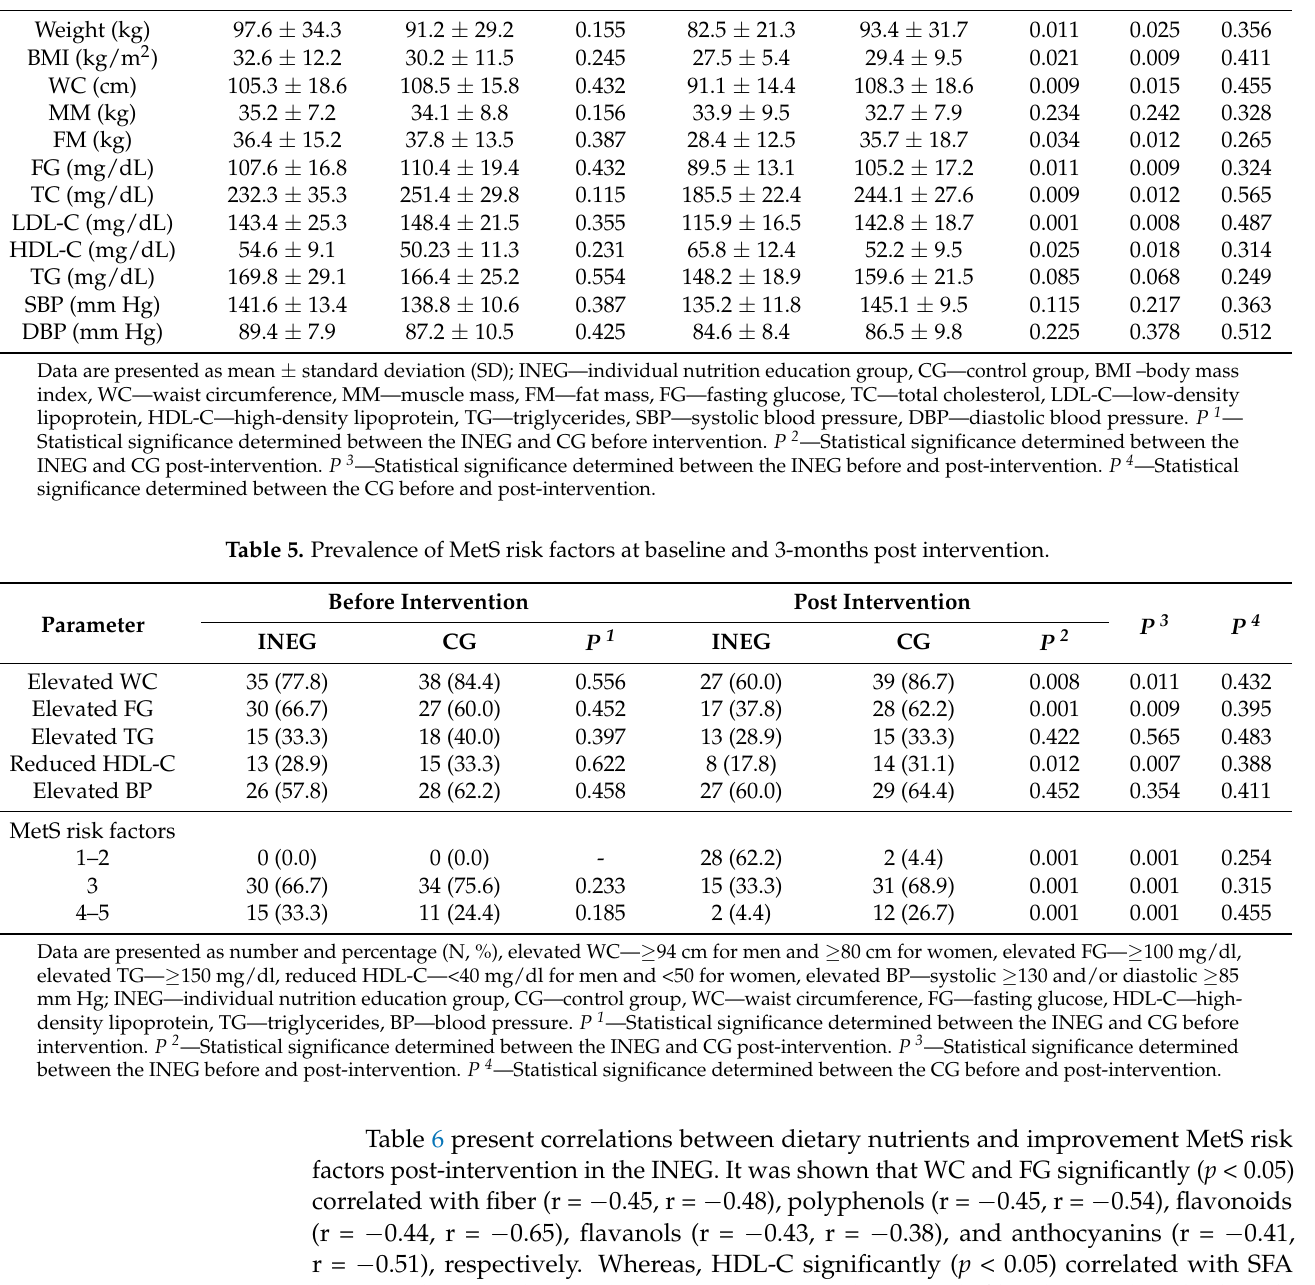
Table 6 present correlations between dietary nutrients and improvement MetS risk factors post-intervention in the INEG. It was shown that WC and FG significantly ( p < 0.05) correlated with fiber (r = − 0.45, r = − 0.48), polyphenols (r = − 0.45, r = − 0.54), flavonoids (r = − 0.44, r = − 0.65), flavanols (r = − 0.43, r = − 0.38), and anthocyanins (r = − 0.41, r = − 0.51), respectively. Whereas, HDL-C significantly ( p < 0.05) correlated with SFA (r = − 0.35), PUFA (r = 0.31), PUFA n-6:n-3 ratio (r = − 0.41), fiber (r = 0.38), polyphenols (r = 0.43), flavonoids (r = 0.48), flavanols (r = 0.42), and anthocyanins (r = 0.45). Table 7 shows the results of a linear regression analysis of dietary polyphenols and MetS risk factors. After the adjustments (model 3), we found significant association between dietary total polyphenols, flavonoids and anthocyanins, and fasting glucose, which explained 35%, 45%, and 32% of the variation,